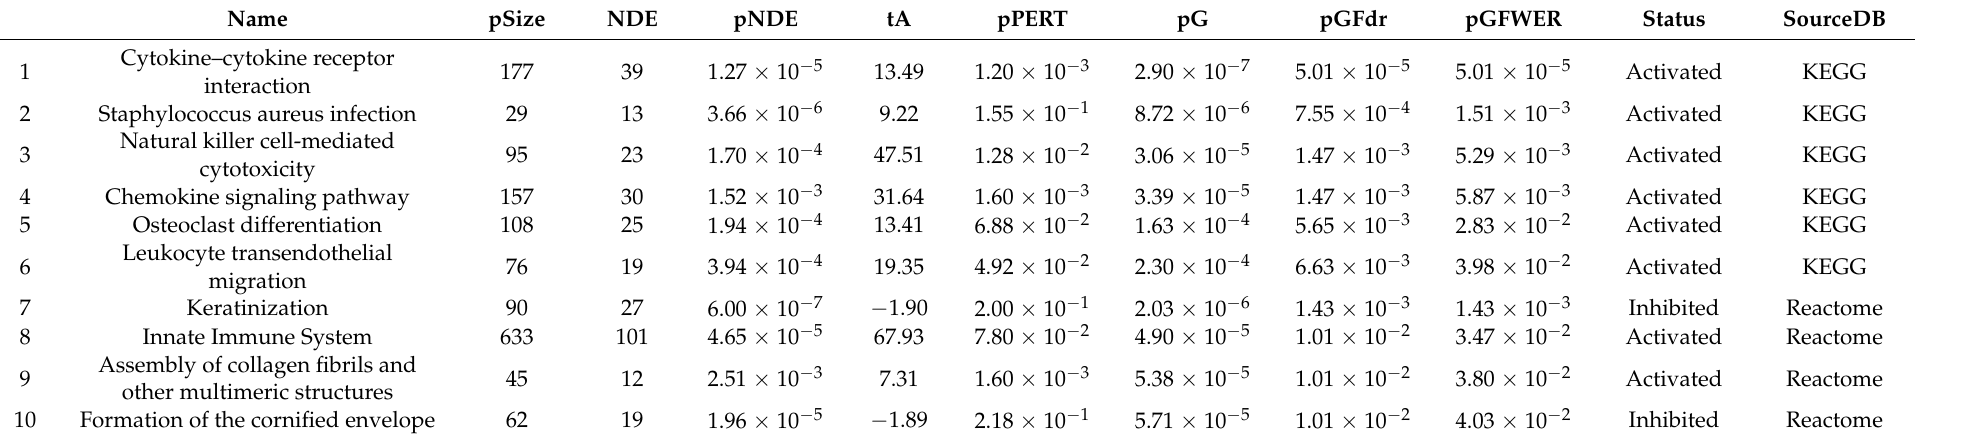
Table 3. Signaling pathways identified as significantly impacted in periodontal diseased gingival tissue by